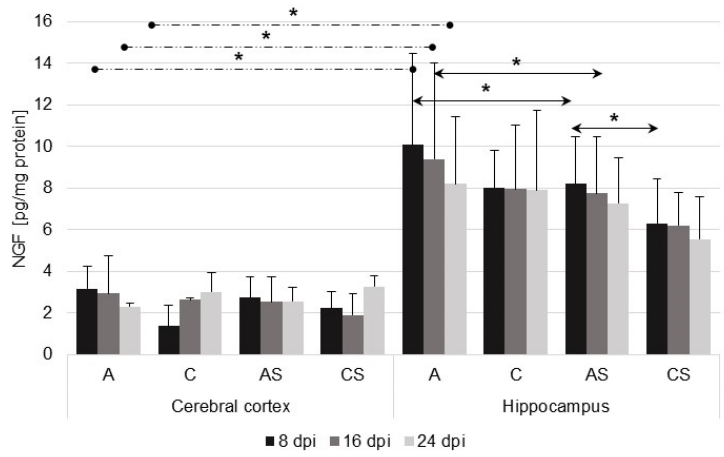
Figure 2. Nerve growth factor (NGF) level (pg/mg protein) in the cerebral cortex and hippocampus in control and infected groups at 8, 16, and 24 days after Acanthamoeba spp. infection (dpi). Data present means ± SD for 6 independent experiments. C, immunocompetent uninfected mice; CS, immunosuppressed uninfected mice; A, immunocompetent Acanthamoeba spp. infected mice; AS, immunosuppressed Acanthamoeba spp. infected mice; solid arrows indicate differences between infected and control mice while dashed arrows indicate differences between brain structures; * p ≤ 0.05 for the significance of difference (Mann–Whitney U